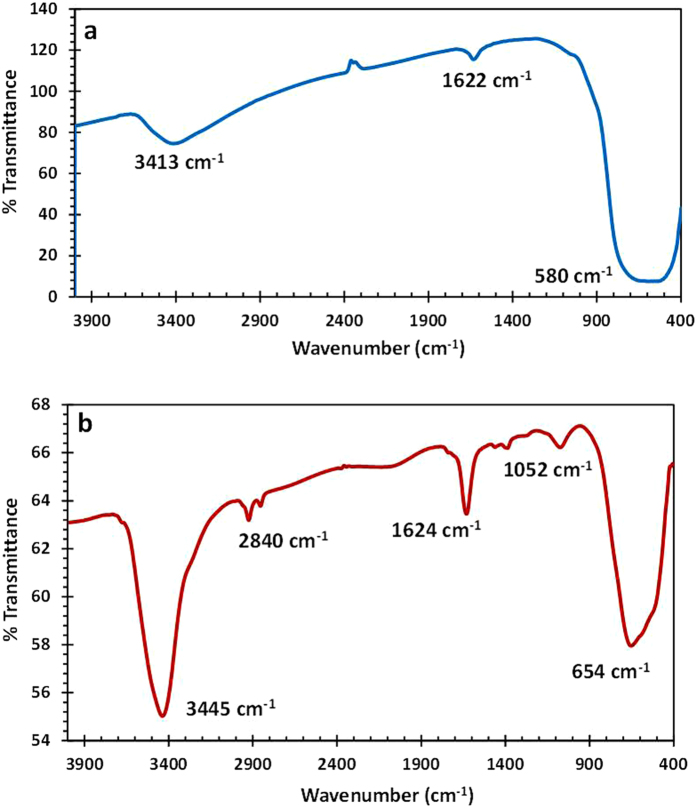
FT-IR spectrum of (a) TiO2 and (b) TiO2-POM film in KBr pellet.